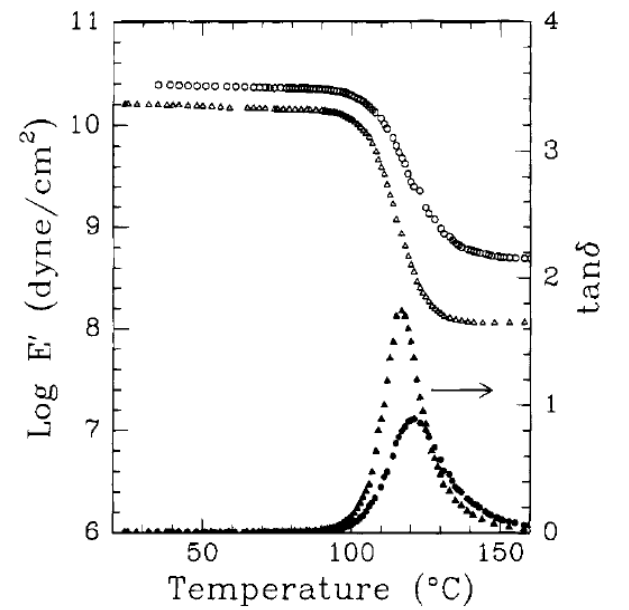
Figure 37. Temperature dependence of E' and tan δ for fully cured DGEBA/BDMA and OMTS/DGEBA/BDMA. Reproduced from reference [86] with permission from The American Chemical Society.